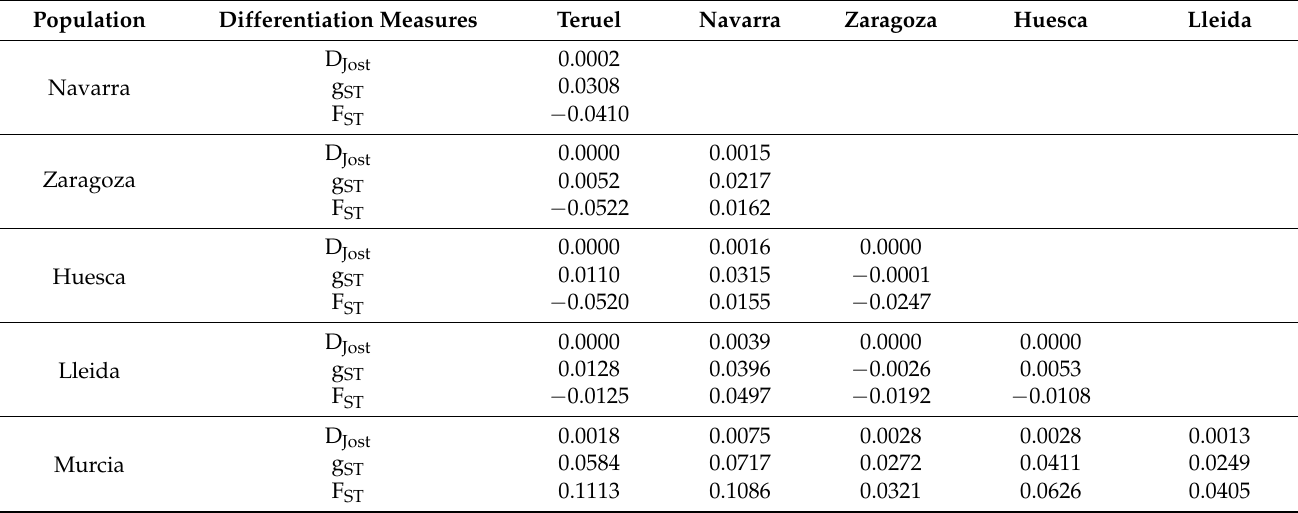
Table 4. Genetic differentiation pairwise